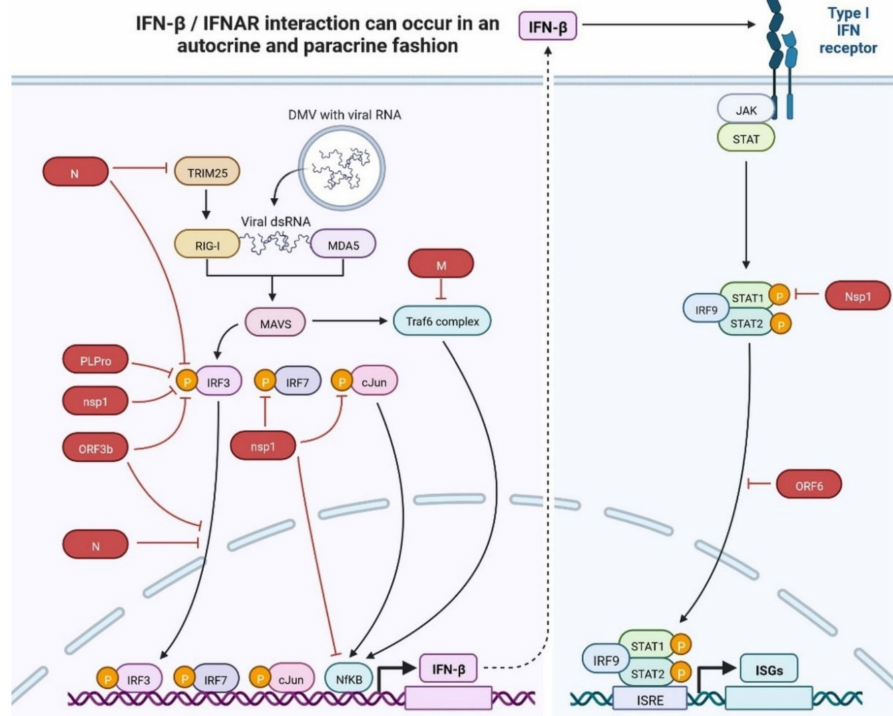
Figure 19. Innate immune antagonism by SARS-CoV. Notes: Red arrow suppression, black arrow activation and dotted arrow slow activation. IFN- β /IFNAR interaction can occur in an autocrine and paracrine fashion. RIG-I and MDA5 are accountable for sensing cytoplasmic viral RNAs. MAVS activates the IRF3 and supresses the regulation viral proteins. Type I interferon activates the ISGs, and the JAK- STAT signalling pathway activates the IRF9-STATcoplex, then subsequently activates the downstream kinases and transcription factors that elicit the production of IFNs and proinflammatory